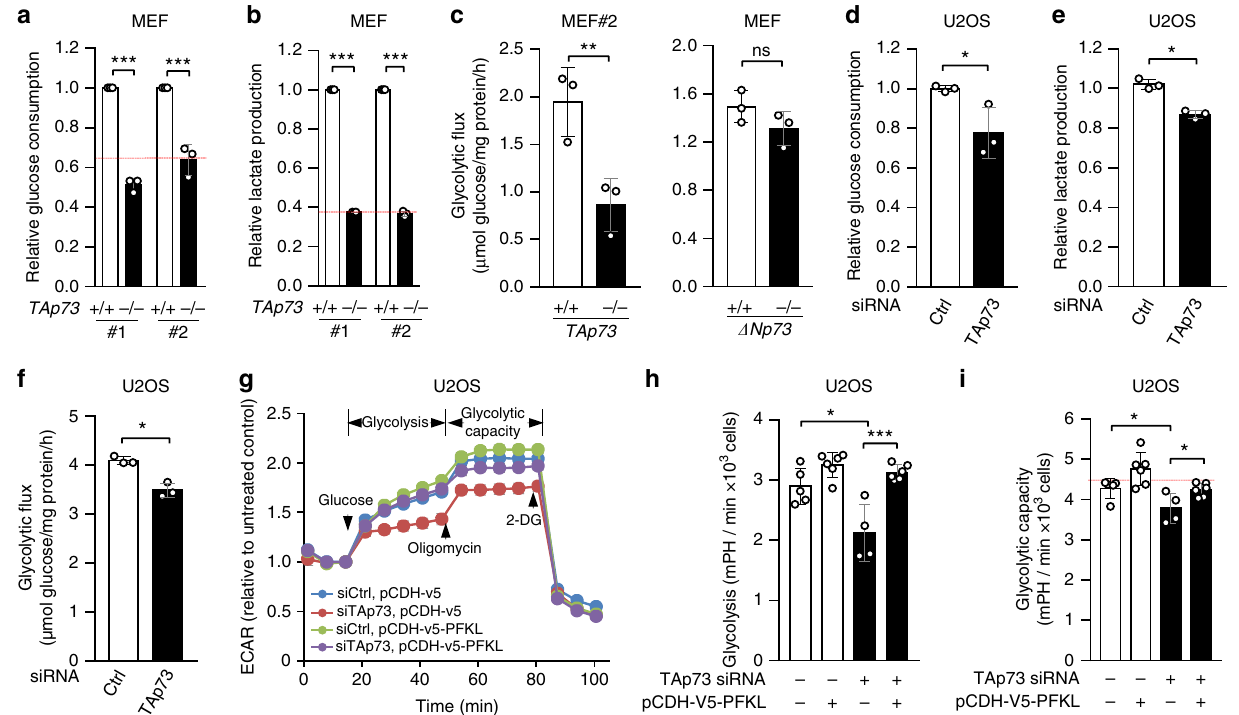
Fig. 1 TAp73 promotes the Warburg effect. a , b Glucose consumption ( a ) and lactate excretion ( b ) in two independent pairs (#1 and #2) of TAp73 + / + and TAp73 − / − MEFs. Data are means ± S.D. ( n = 3 independent experiments). c TAp73 + / + and TAp73 − / − MEFs (left), or Δ Np73 + / + and Δ Np73 − / − MEFs (right) were cultured in medium containing [1,2 – 13 C 2 ]glucose. Glycolytic fl ux was measured on the base of glucose consumption rate and the generation of 13 C-labeling lactate (M2) determined by LC-MS. Data are means ± S.D. ( n = 3). d – f U2OS cells treated with control (Ctrl) or TAp73 siRNA were assayed for glucose consumption ( d ), lactate excretion ( e ), and glycolytic fl ux ( f ). Data are means ± S.D. ( n = 3) g – i , U2OS cells stably transfected with control plasmid (pCDH-V5) or PFKL plasmid (pCDH-v5-PFKL) were treated with control or TAp73 siRNA. Cells were supplied with 10 mM glucose, 2 μ M oligomycin, and 100 mM 2-DG at the indicated times. ECAR was examined using Seahorse XFe96 analyzer ( g ). Relative glycolysis levels ( h ) and glycolytic capacity ( i ) are normalized to the cell number (means ± S.D., n =